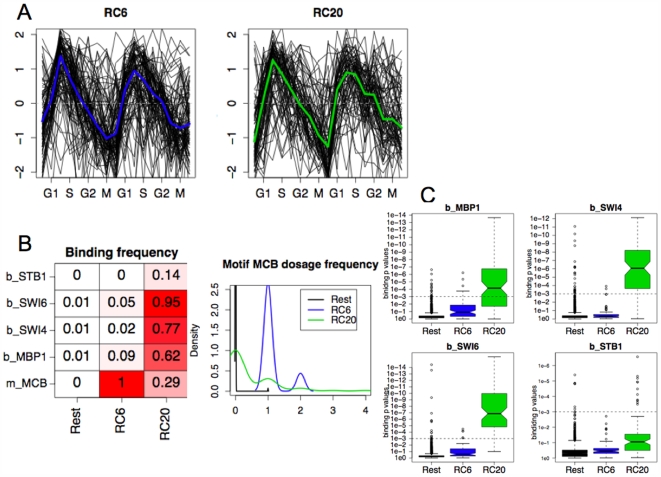
Comparisons of RC6 and RC20 uncovered in yeast cell cycle data by Cho et al. using both motifs and TF-binding as predictors.A Expression profiles of constituent genes. B Left: binding and motif frequency of feature regulons in the two RCs; Right: MCB motif dosages in the two RCs. C Boxplots of binding p-values of the four binding TFs comparing RC6, RC20 and the rest of the genes.